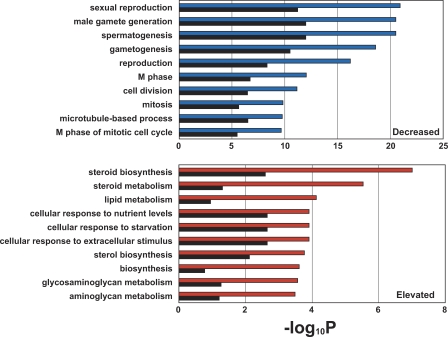
Comparison of Ten Top-ranked Gene Ontology (GO) Categories Significantly Over-Represented in the Two Subsets (1,709 Decreased, Upper Panel; 903 Elevated, Lower Panel) of NOA-related Target GenesBlue and red bars represent p-values for the ten top-ranked GO categories over-represented in the decreased and elevated gene lists, respectively. Black bars show the corresponding p-value using 2,611 NOA-related target genes. p-Values were determined by Fisher's exact test using all of the GO-annotated genes on the Agilent Human 1A(v2) microarray as a background, as shown in Table 1. The p-values are expressed as the negative logarithm (base 10).